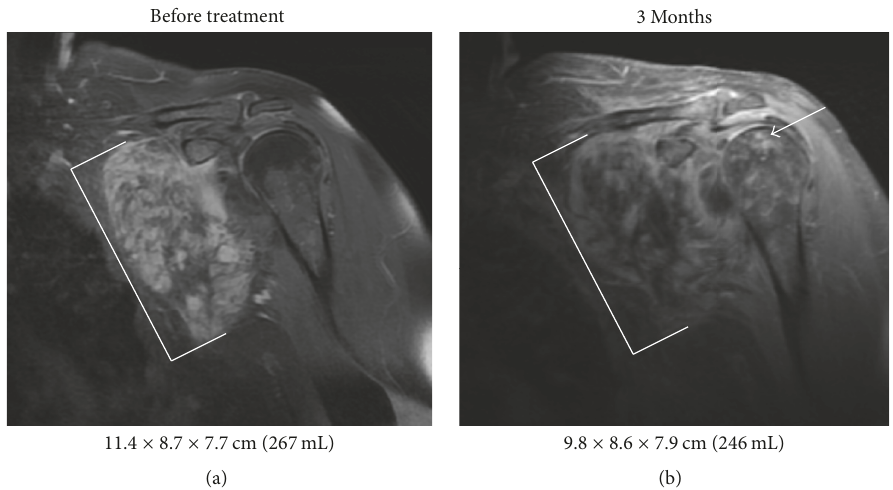
Figure 2: Imaging of Axillary Desmoid Treatment Response. Coronal T1 postcontrast MRI of a left axillary desmoid tumor before (a) and 3 months after (b) completing radiation therapy to 50.4 Gy in 28 fractions with concurrent imatinib demonstrating decreased enhancement with minimal change in tumor size. The tumor is delineated with white brackets. Imaging changes noted in the humeral head compatible with avascular necrosis are indicated with the white